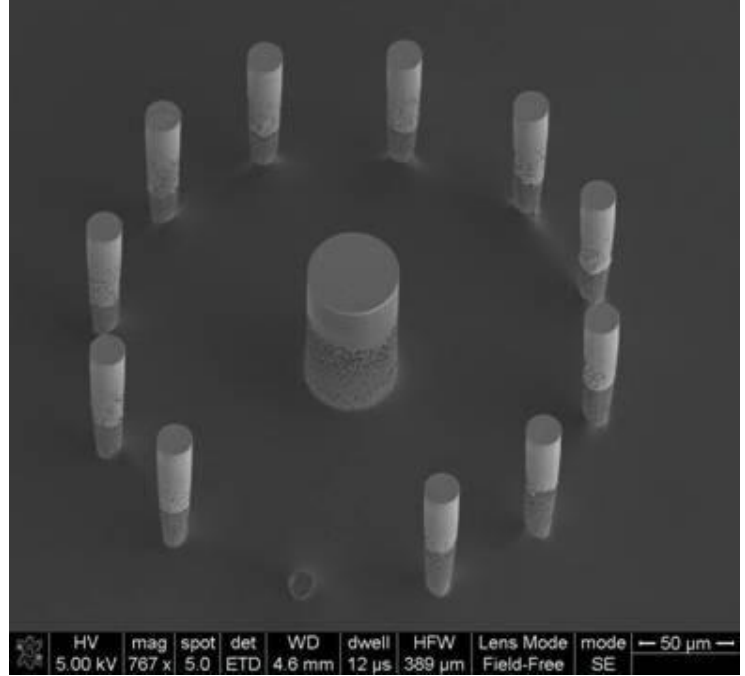
Figure 1. SEM image of electrodes partially metalized by sputtering. The image shows a clear example of how the walls of the electrodes are not covered by the metal layer at the bottom of the structures, which leaves them unconnected to the external